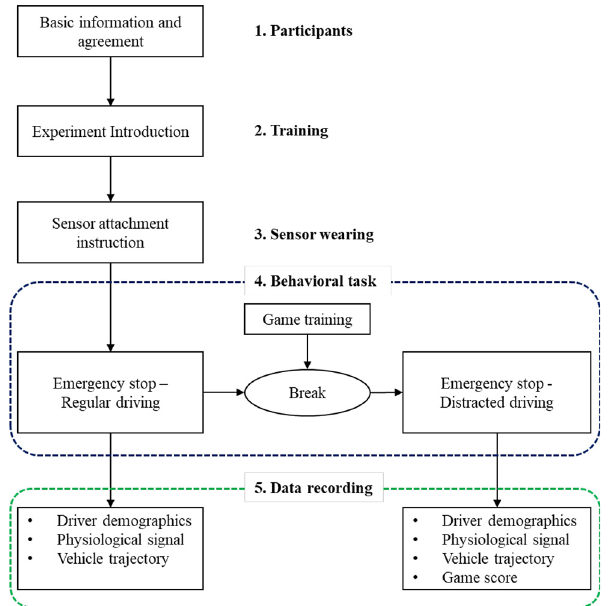
Figure 4 Data acquisition procedure